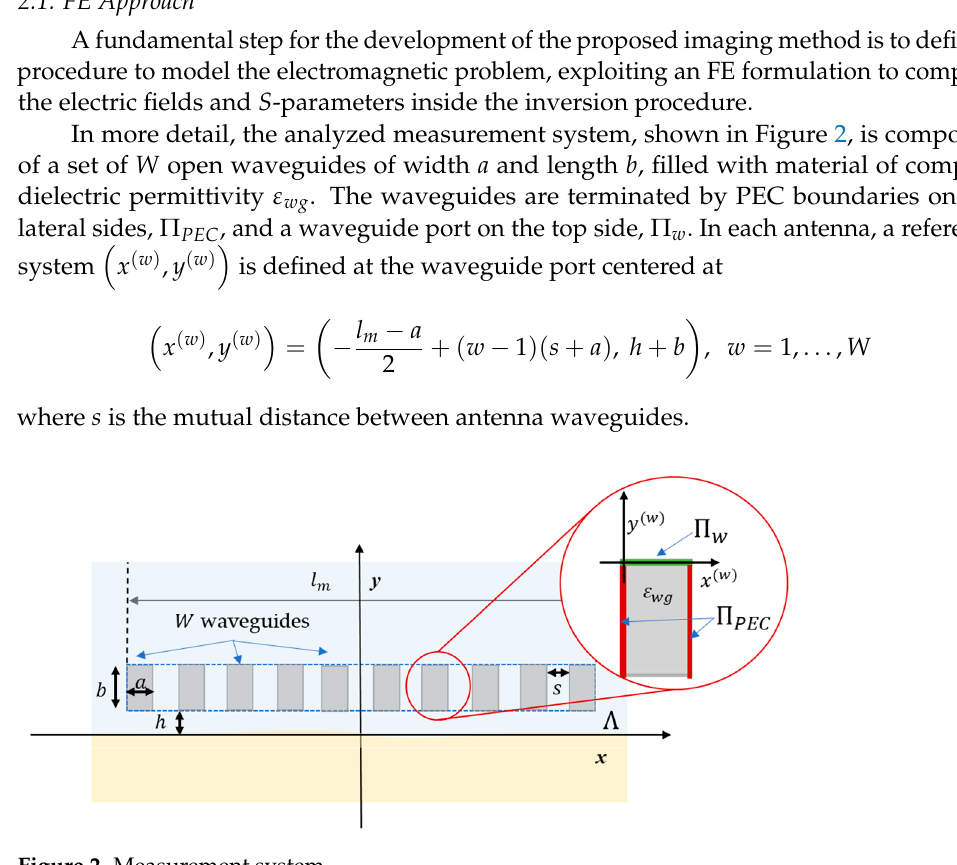
Figure 2. Measurement